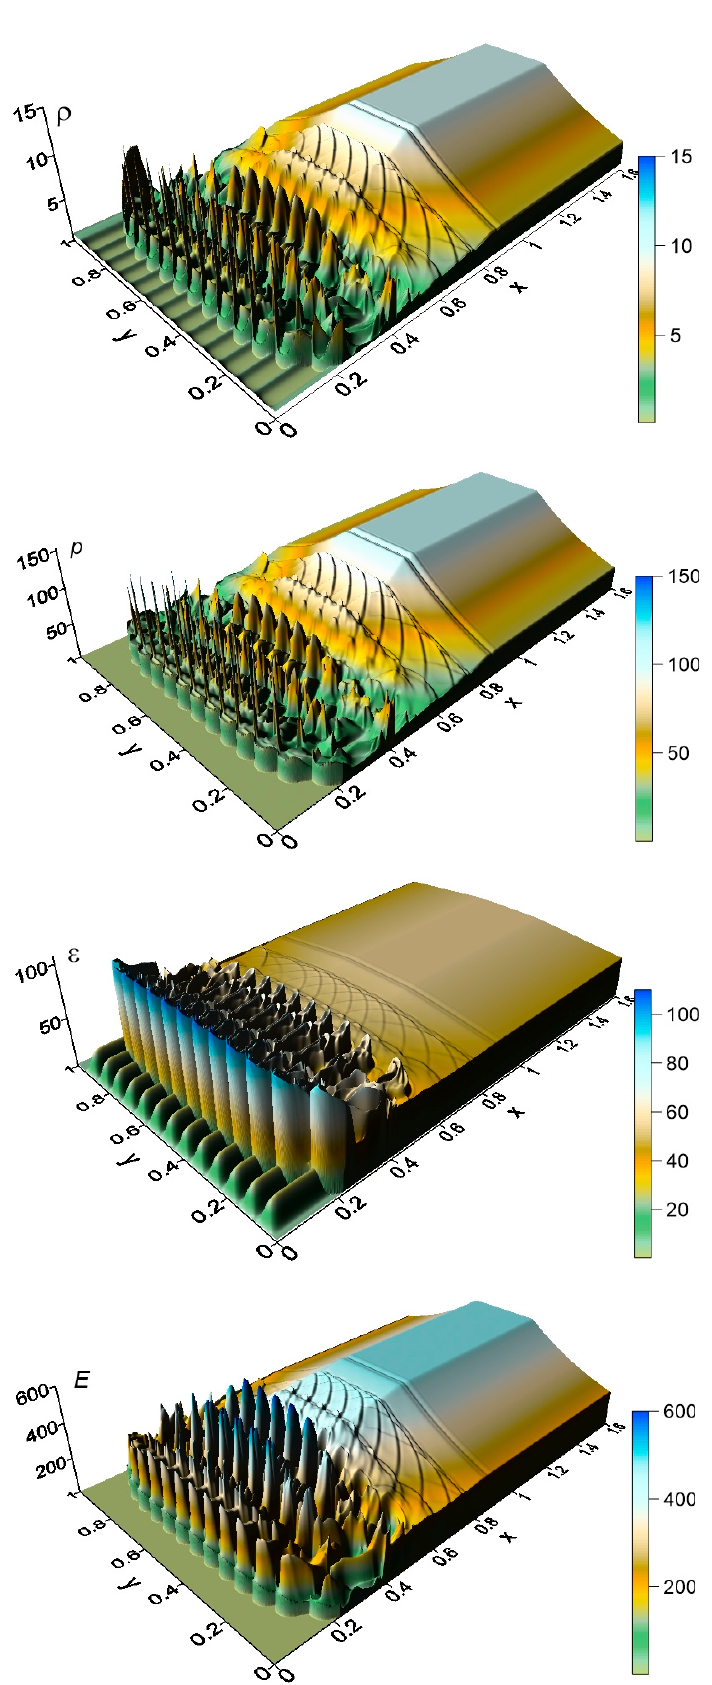
Figure 8. Fields of the considered parameters ( ρ , p , ε and E ): M = 10, α = 0.1, t = 0.1.